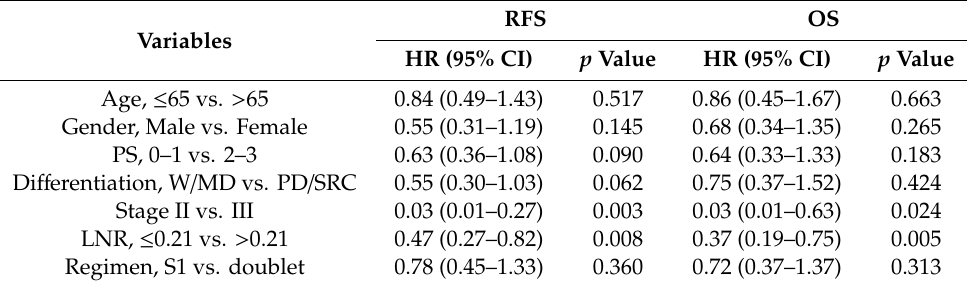
Table 2. Cox regression analysis of parameters associated with